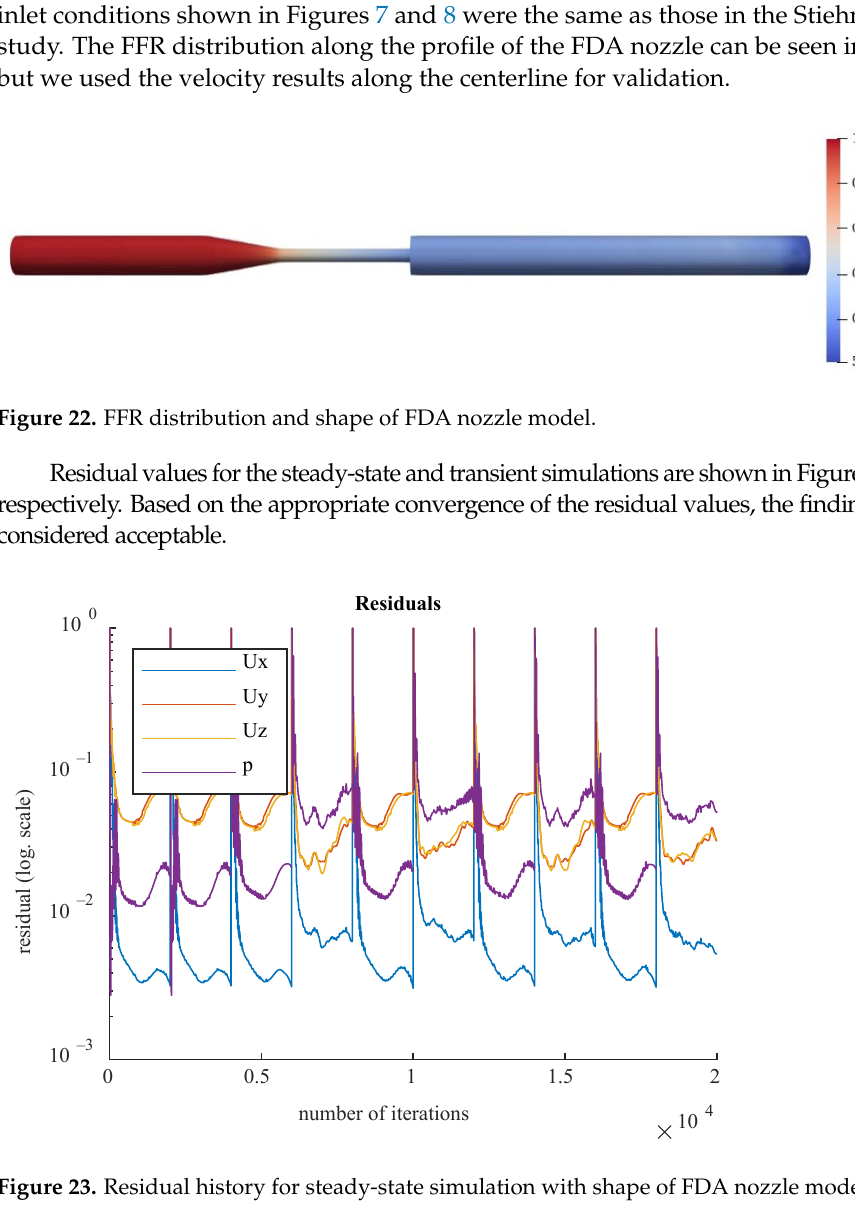
( b ) Figure 24. Residual histories for transient sinus ( a ) and waveform ( b ) with shape of FDA nozzle model .